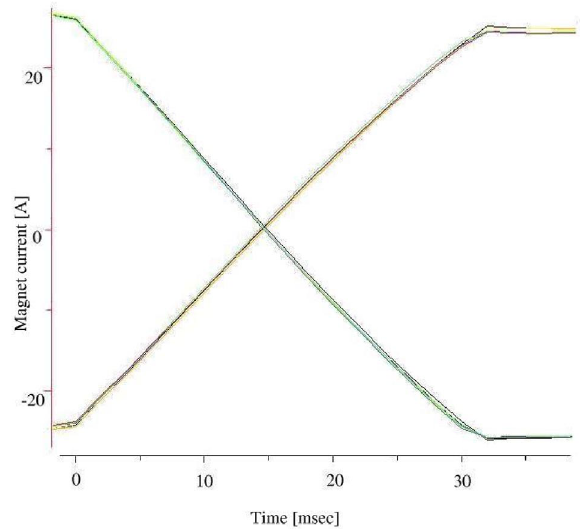
FIG. 5. (Color) Measured magnet currents during the transi- tion jump in the BLUE ring. The total jump duration is about 30 ms; the 12 involved power supplies track within 1